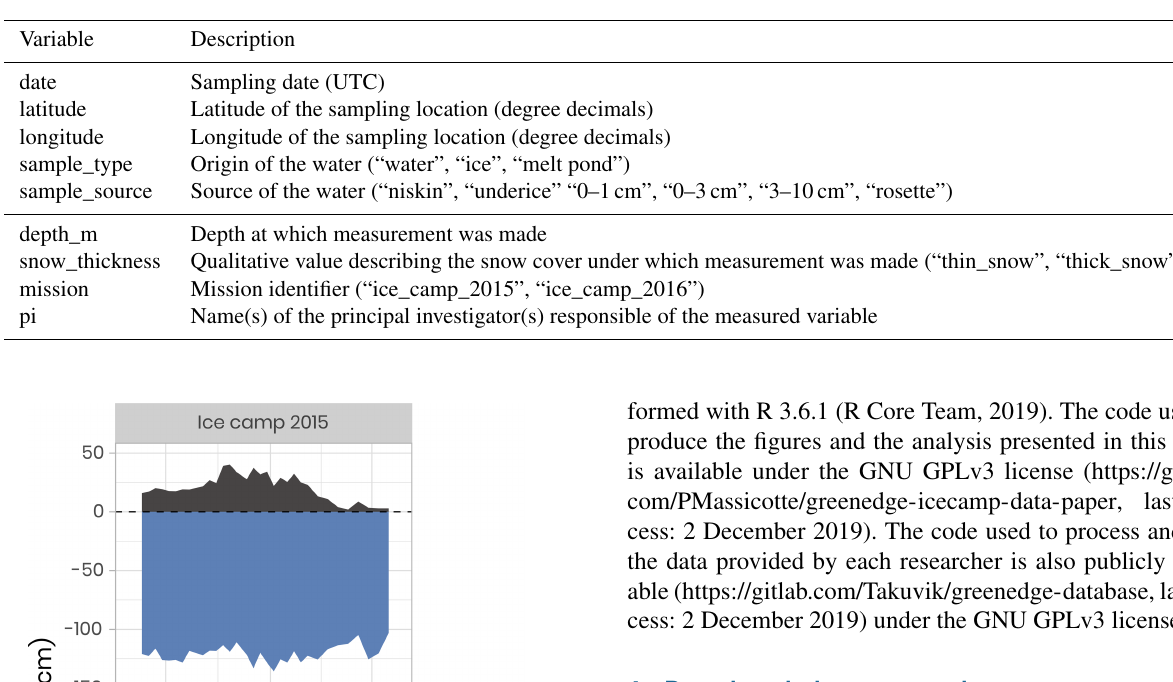
Table 1. Descriptions of the minimal variables included in each dataset (i.e., in each CSV file).